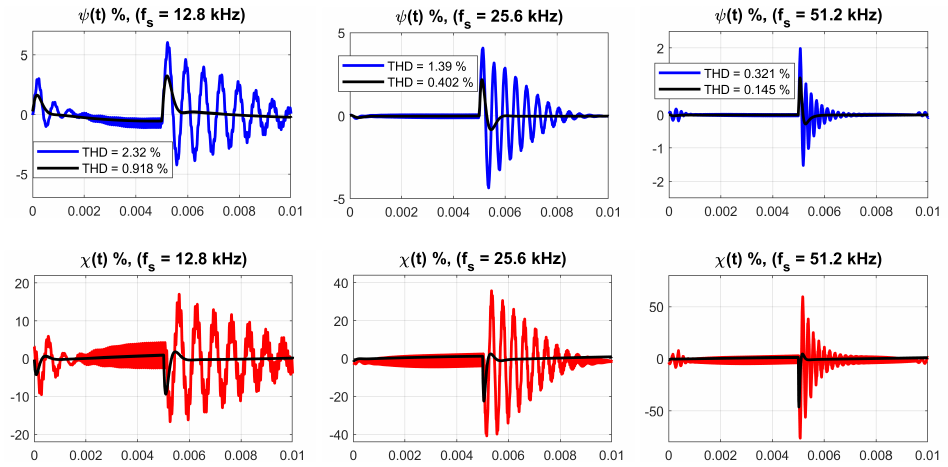
Figure 22. Effect of sampling on control performance. The black lines represent responses with the fictitious no-delay controller C ∗ ( s ) , and the colored lines with the real controller C ( s ) . The higher the gain the lower the values of ψ ( t ) during the no-load period with with the fictitious no-delay controller C ∗ ( s )